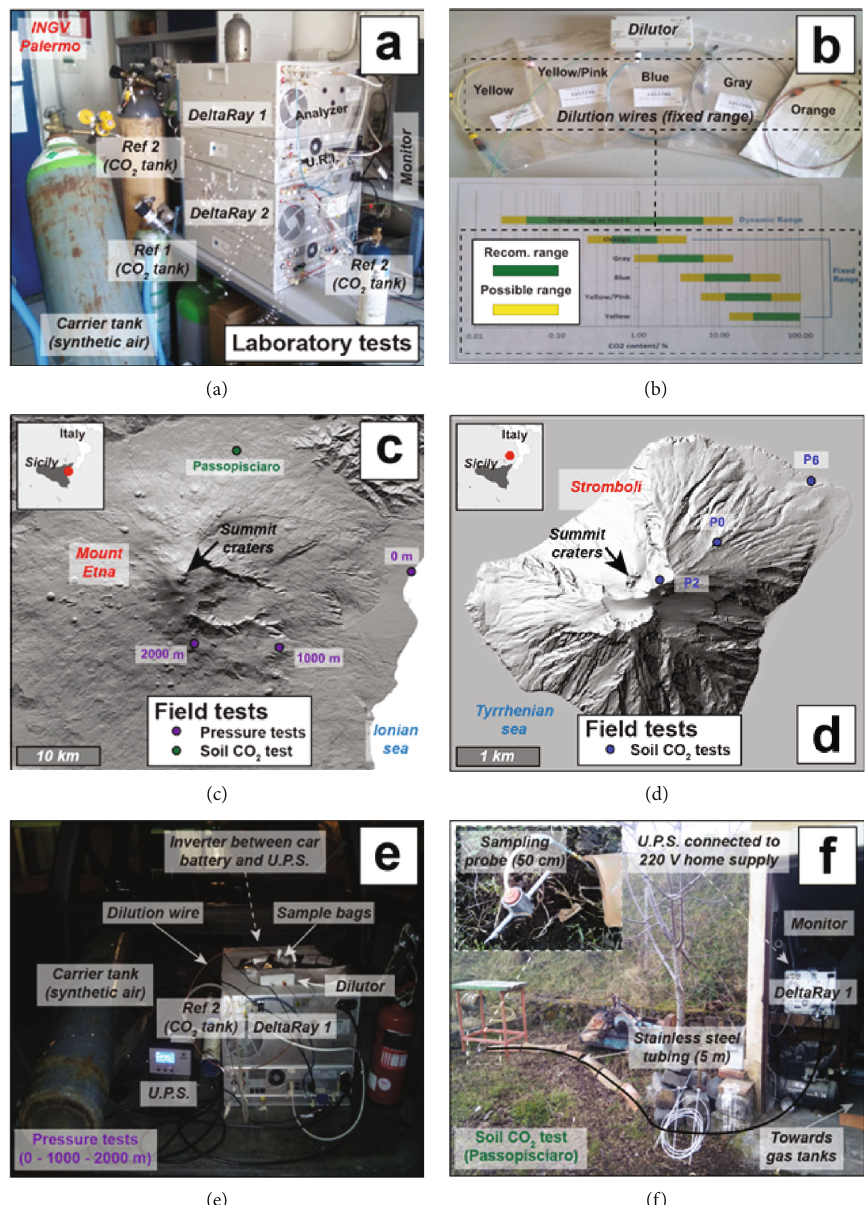
Figure 1: Description of deployed material and location of sample sites. (a) Deployment of the Delta Ray IRIS in the INGV